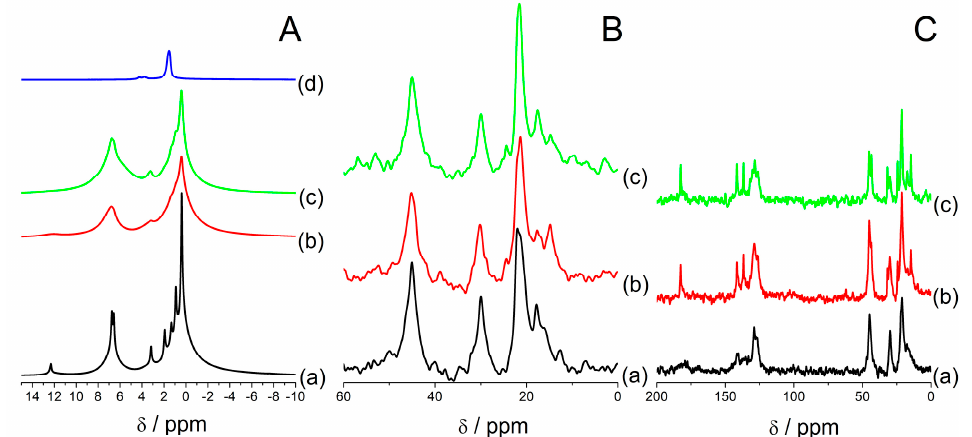
Figure 7. 1 H ( A ), 13 C HPDEC ( B ), 13 C CP ( C ) MAS NMR spectra of sample containing 28% of mass